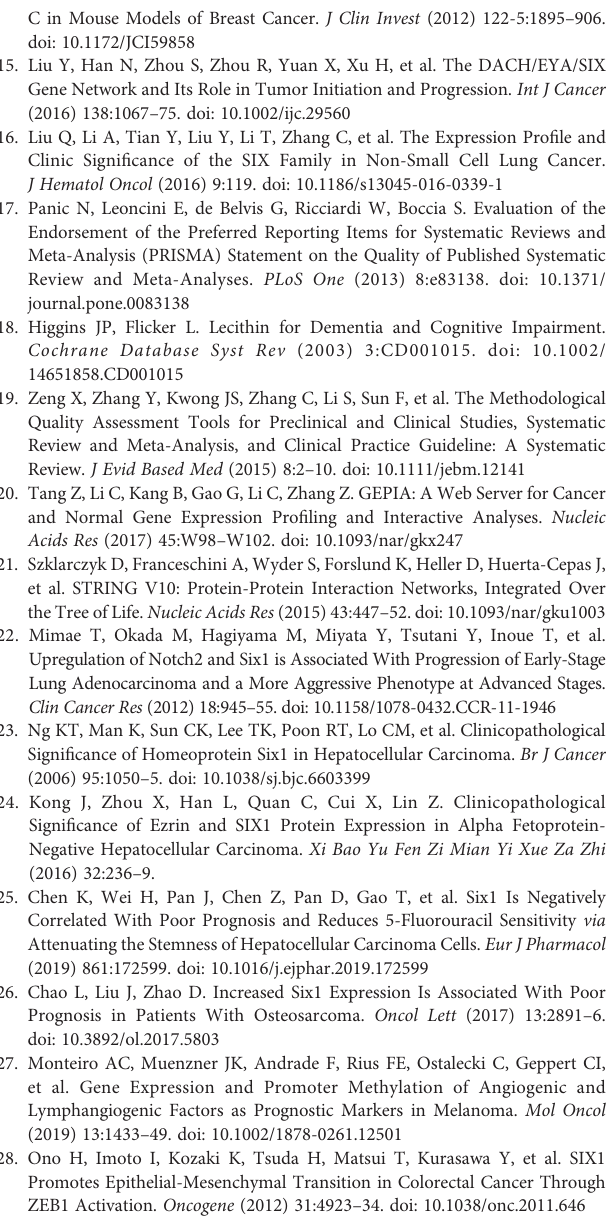
Supplementary Figure 1 | Mechanisms prediction of SIX1-related genes with bioinformatics and enrichment. (A) The protein-protein interaction network of SIX1- related genes. (B) The functional enrichment analysis of SIX1-related